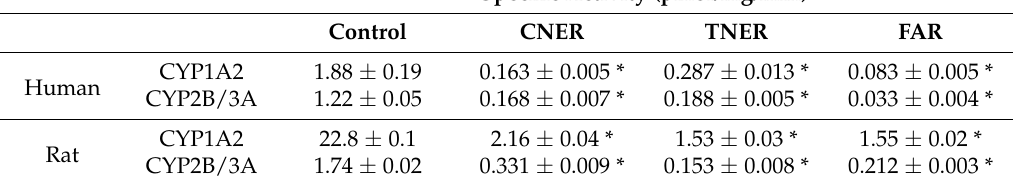
Table 1. Specific activities of CYP1A2 (EROD activity) and CYP2B/3A (BROD activity) in human and rat liver subcellular fractions—controls and samples in the presence of 100 µ M sesquiterpenes CNER, TNER and